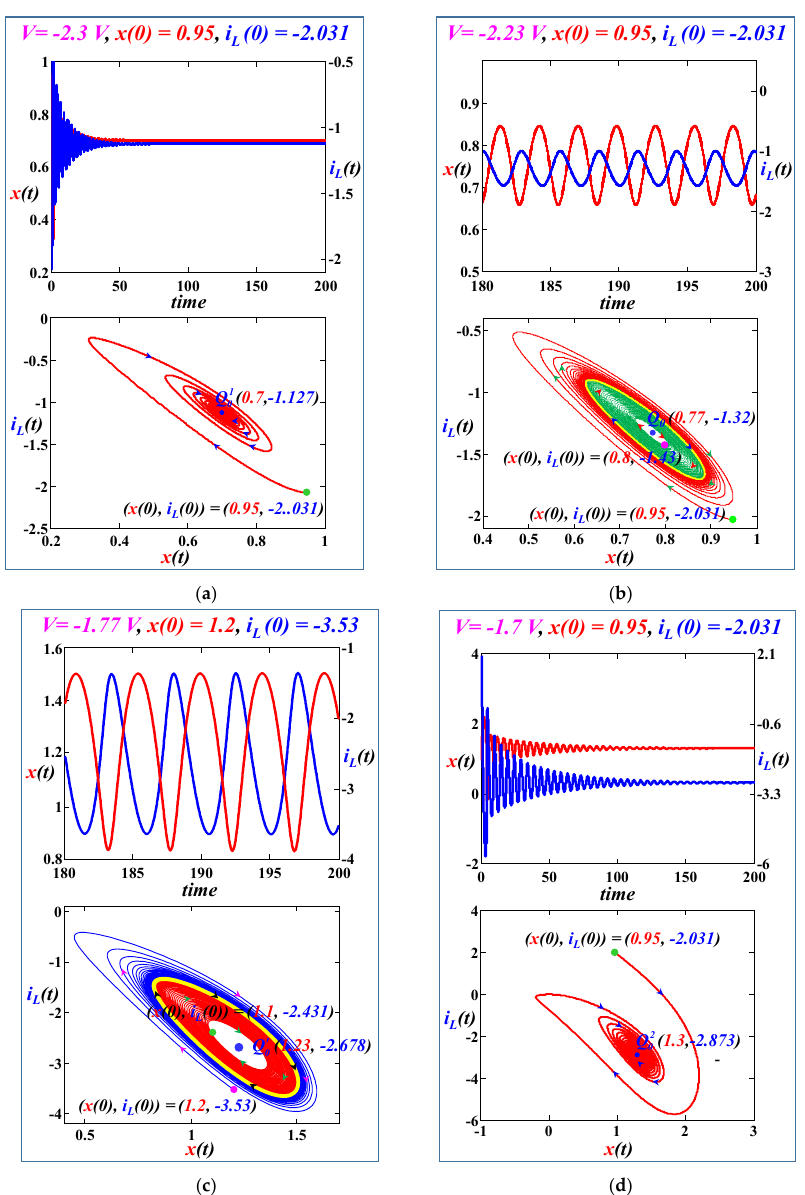
Figure 7. Numerical simulation results of supercritical Hopf bifurcation theorem of 6-lobe CCM oscillator circuit with external inductor L* = 355.5 mH. ( a ) Transient waveform converges to Q 1 ( 0.7, − 1.127) for V = −2.3 V with initial condition ( x(0), i L (0) ) = (0.95, −2.031), ( b ) Transient waveforms generated from two di ff erent initial states ( x (0), i L (0)) = (0.95, − 2.031) and ( x (0), i L (0)) = (0.8, − 1.43) converge to a yellow limit cycle for V = − 2.23 V, ( c ) Transient waveforms generated from two di ff erent initial states ( x (0), i L (0)) = (1.1, − 2.431) and ( x (0), i L (0)) = (1.2, − 3.53) converge to a large yellow limit cycle for V = − 1.77 V, and ( d ) Transient waveform converges to Q 2 (1.3, − 2.873) for V = − 1.7V with initial condition ( x (0), 0 i L (0)) = (0.95, −